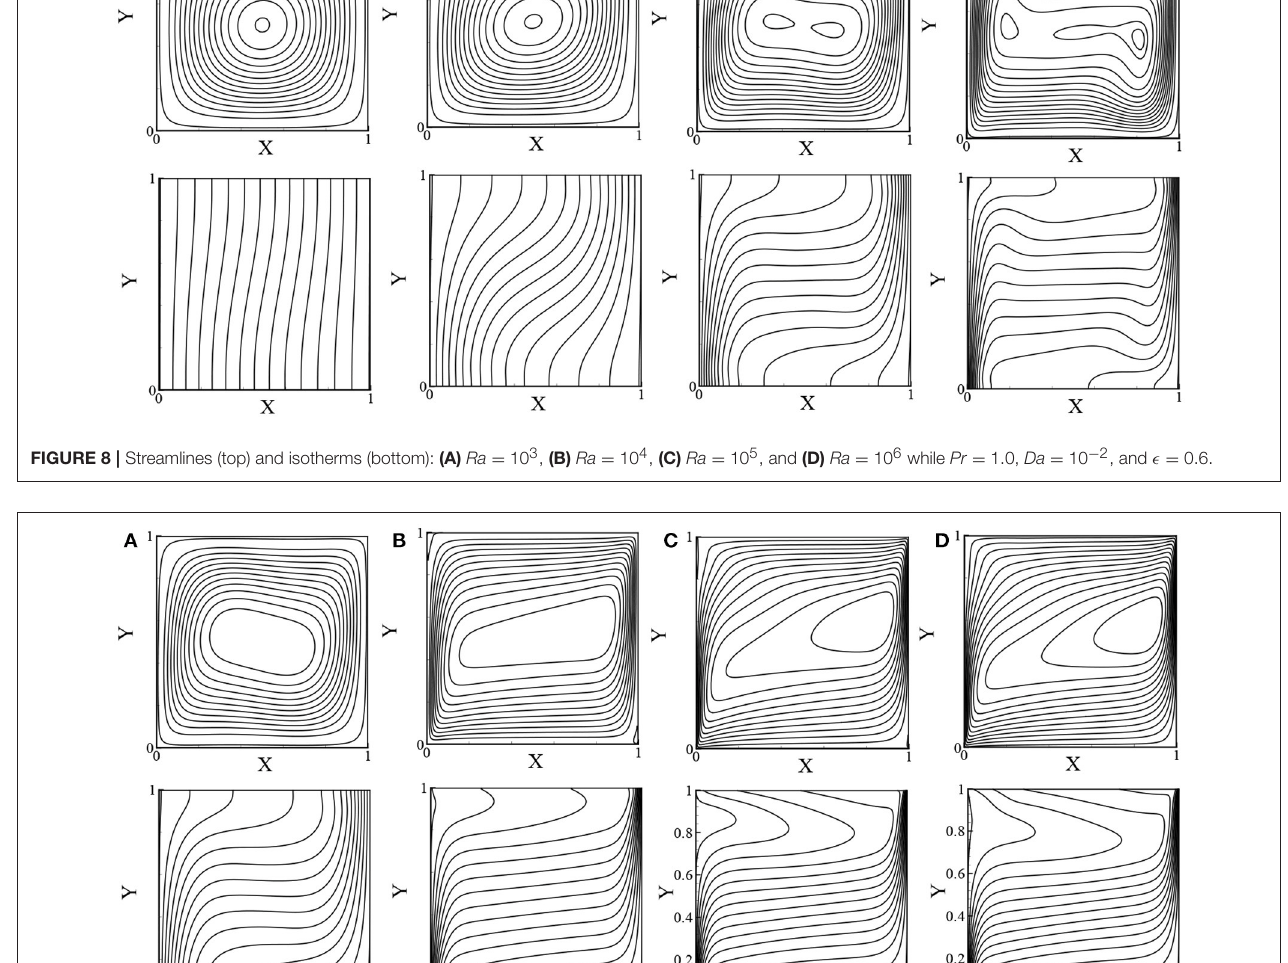
FIGURE 9 | Streamlines (top) and isotherms (bottom) for (A) Da Ra 10 10 while Pr =